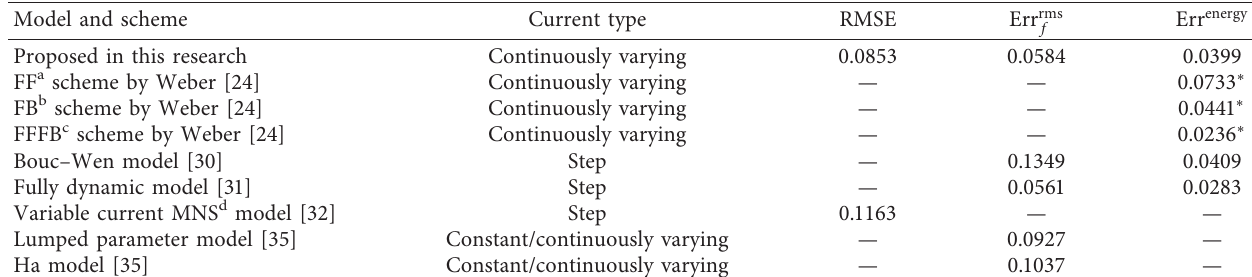
Figure 10: Comparison of i and i . (a) Positive stiffness ( c sim act � 10N/m · s , k � − 100N/m). ( c des des Table 5: Error comparison of different models and